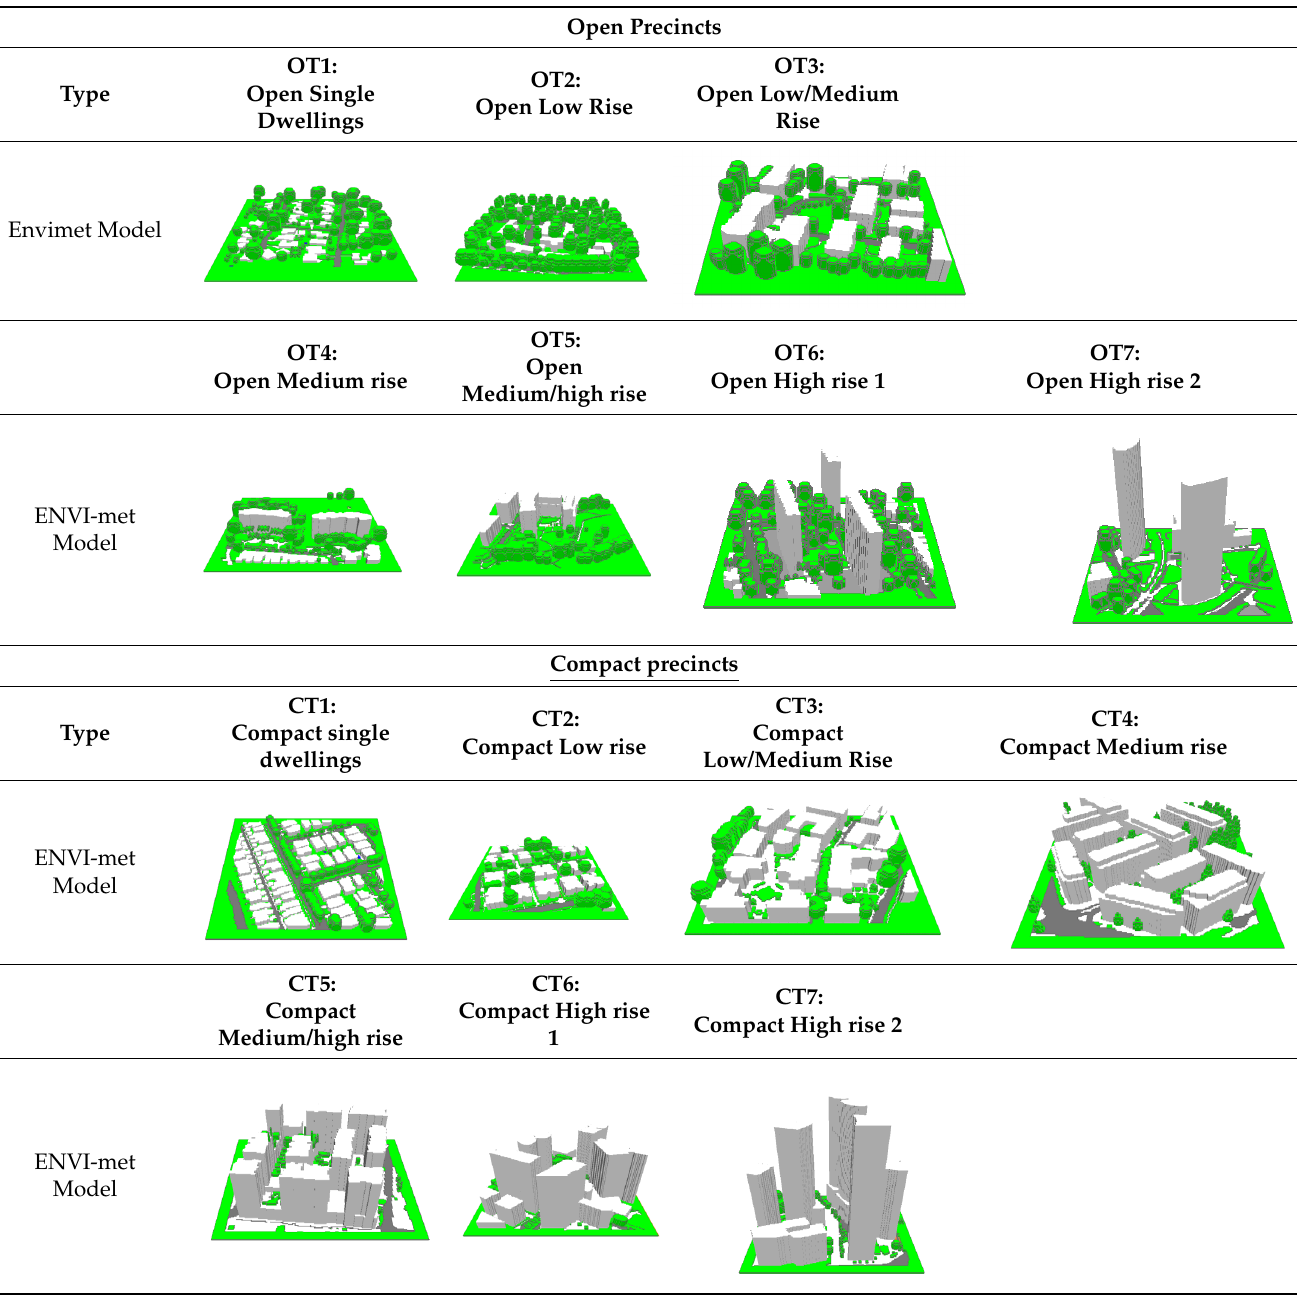
Table 7. The models developed in ENVI-met for all typologies and the mitigated scenarios.